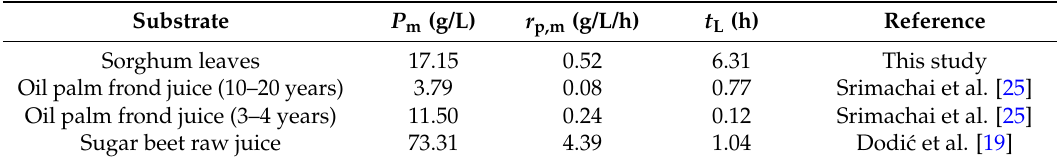
Table 2. Comparison of modified Gompertz model parameters with previous